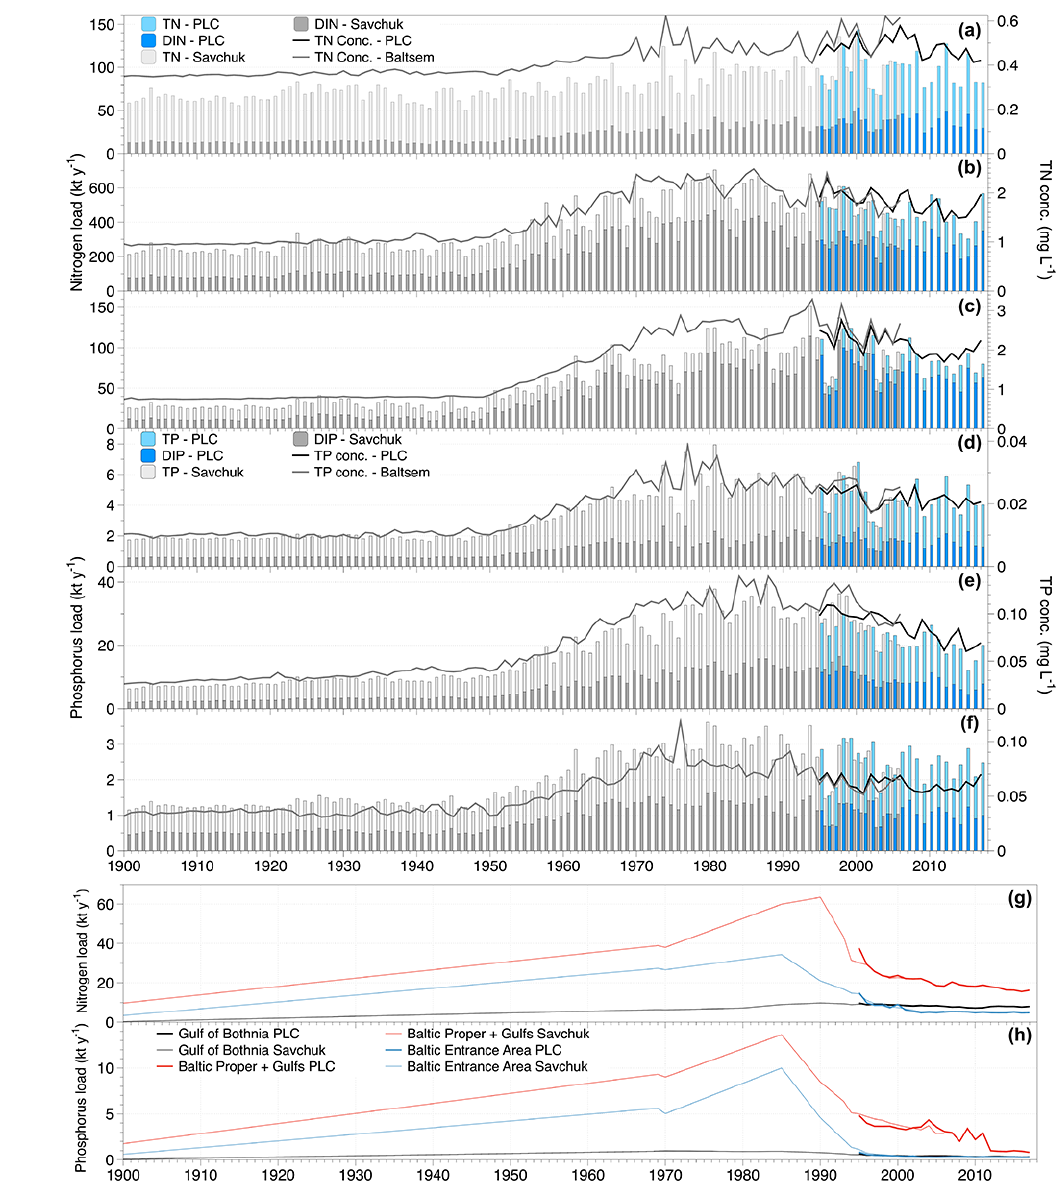
Figure 2. Nitrogen ( a – c and g ) and phosphorus (panels d – f and h ) nutrient load time series. Total and inorganic riverine loads of nitrogen and phosphorus, respectively, are shown as bars, and flow-weighted concentrations of total nutrients calculated from the annual load and flow are shown as lines. The riverine loads to the Gulf of Bothnia are shown in panels (a) and (d) , the Baltic Proper plus the gulfs of Riga and Finland in panels (b) and (e) , and the Baltic entrance area (Kattegat, the Sound, and Belt Sea) in panels (c) and (f) . In panels (g) and (h) the loads from coastal direct point sources are drawn for total nitrogen and total phosphorus, respectively. The colouring of the bars and lines reflects that loads are assessed from two sources (Savchuk et al., 2012a, b, grey bars, and the HELCOM PLC (HELCOM, 2019) for total nutrients and directly from the HELCOM PLC water database for the inorganic nutrients; blue